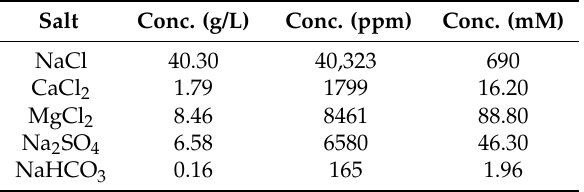
Table 1. Concentration of salts in prepared seawater, based on concentrations native to the Persian Gulf